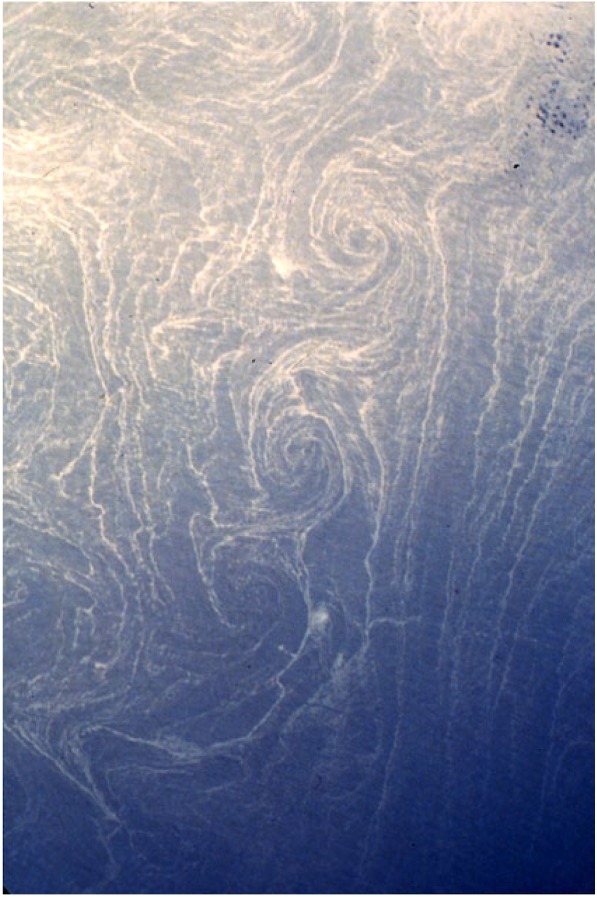
Sun-glintshowing ‘spirals on the sea’ not far off the Mediterranean coast of Africa photographed from space [19,20]. The vortex radii are ≈5 km and the high surfactant concentration c occurs in convergence lines that are hundreds of metres wide, probably due to dense filament arms in a spiral configuration inside the vortices. The pattern suggests a vortex-street roll-up has occurred from a lateral shear instability of some parent front, filament or topographic wake.